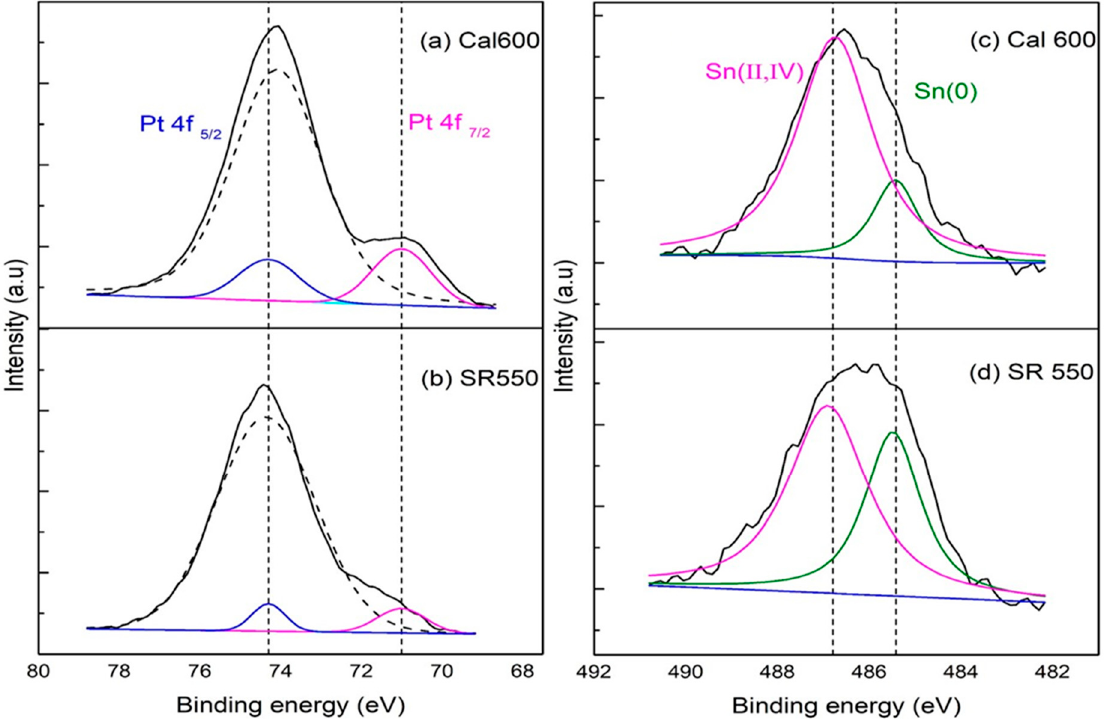
Figure 8. XPS Pt 4f spectra of ( a ) SR550, ( b ) Cal 600 and Sn 3d spectra of ( c ) SR550, and ( d ) Cal 600.